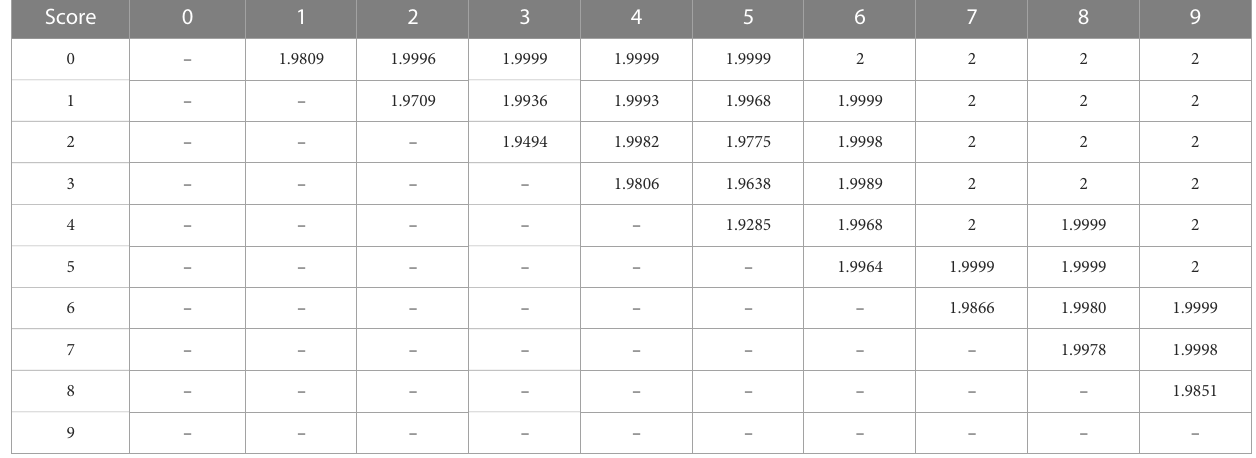
TABLE 6 The J-M distance between all 10 disease scores for spectral separability using bands selected from GA-PLS.